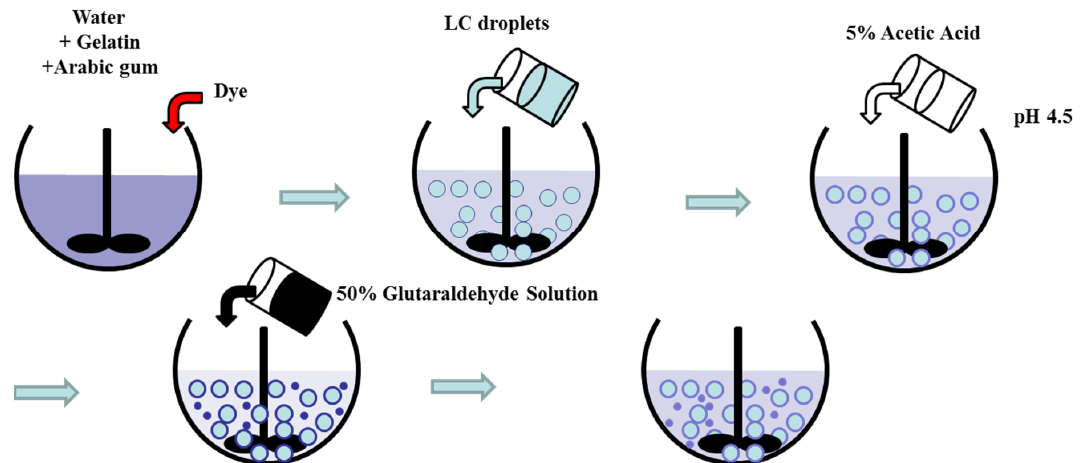
Figure 3. Preparation process of the core–shell structured liquid crystal microcapsule. First, a 5